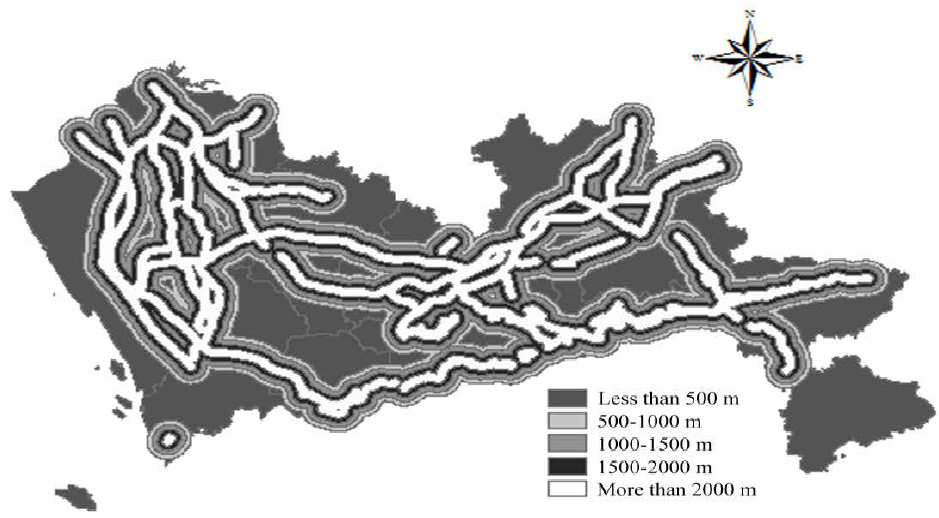
Figure 14. Map of distance to main road.